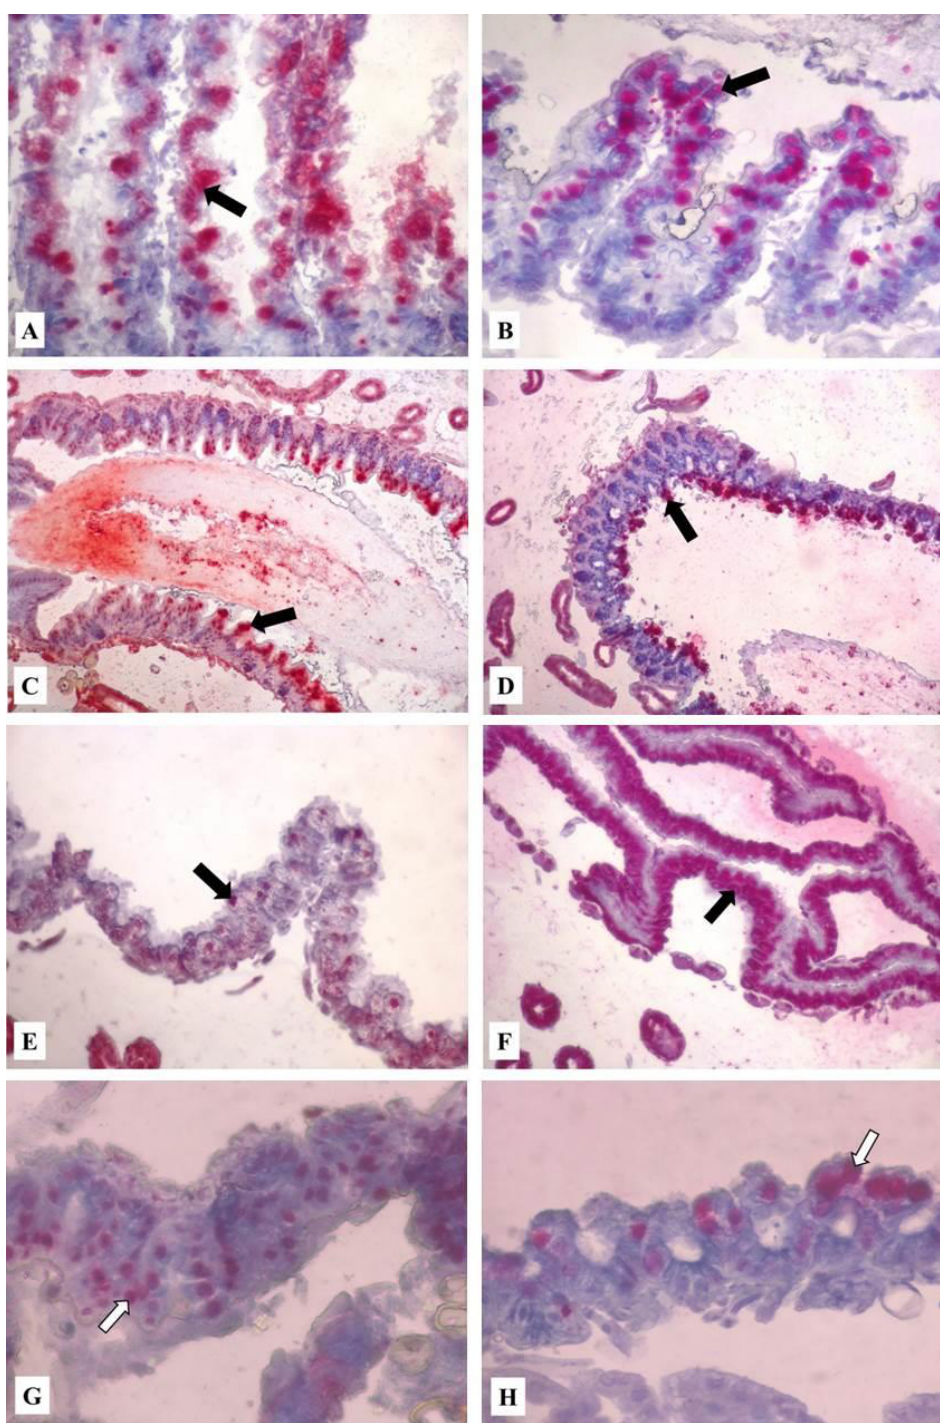
Figure 4. Midgut of formalin-fixed, para ffi n-embedded tissue of worker bees exposed to HMF. Detection of programmed cell death by TUNEL using the In Situ Cell Death Detection Kit. Red azo-dye staining is localized in midgut epithelial cell nuclei (arrows). ( A ) 100 mg / kg of HMF in Apifonda diet (5 days), magnification 200 × ; ( B ) 500 mg / kg of HMF (5 days), magnification 200 × ; ( C ) 100 mg / kg of HMF (10 days), magnification 100 × ; ( D ) 1500 mg / kg of HMF (10 days), magnification 100 × ; ( E ) control group (15 days), magnification 200 × . ( F ) 1000 mg / kg of HMF (15 days), magnification 200 × ; ( G ) 500 mg / kg of HMF (20 days), magnification 400 × ; ( H ) control group (5 days), magnification 400 × . The dosage of HMF was incorporated to 1 kg of Apifonda candy.